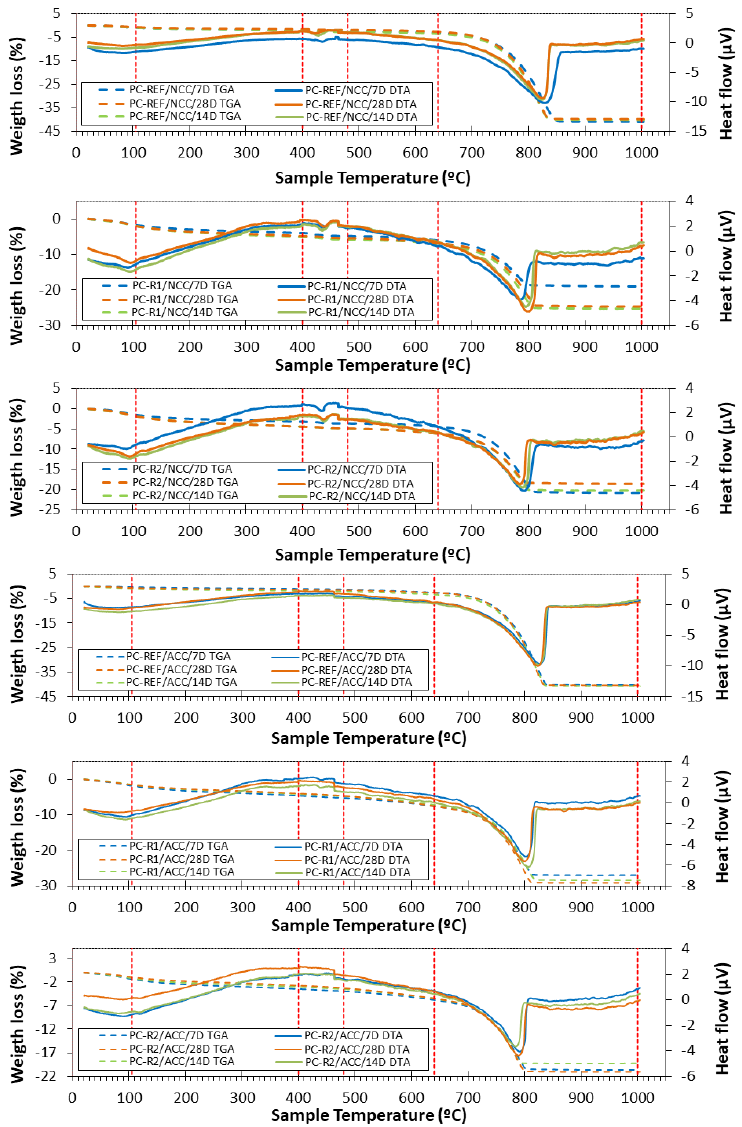
Figure 8. TGA and DTA of the different mixtures at 7, 14 and 28 days of curing in NCC and ACC environment.